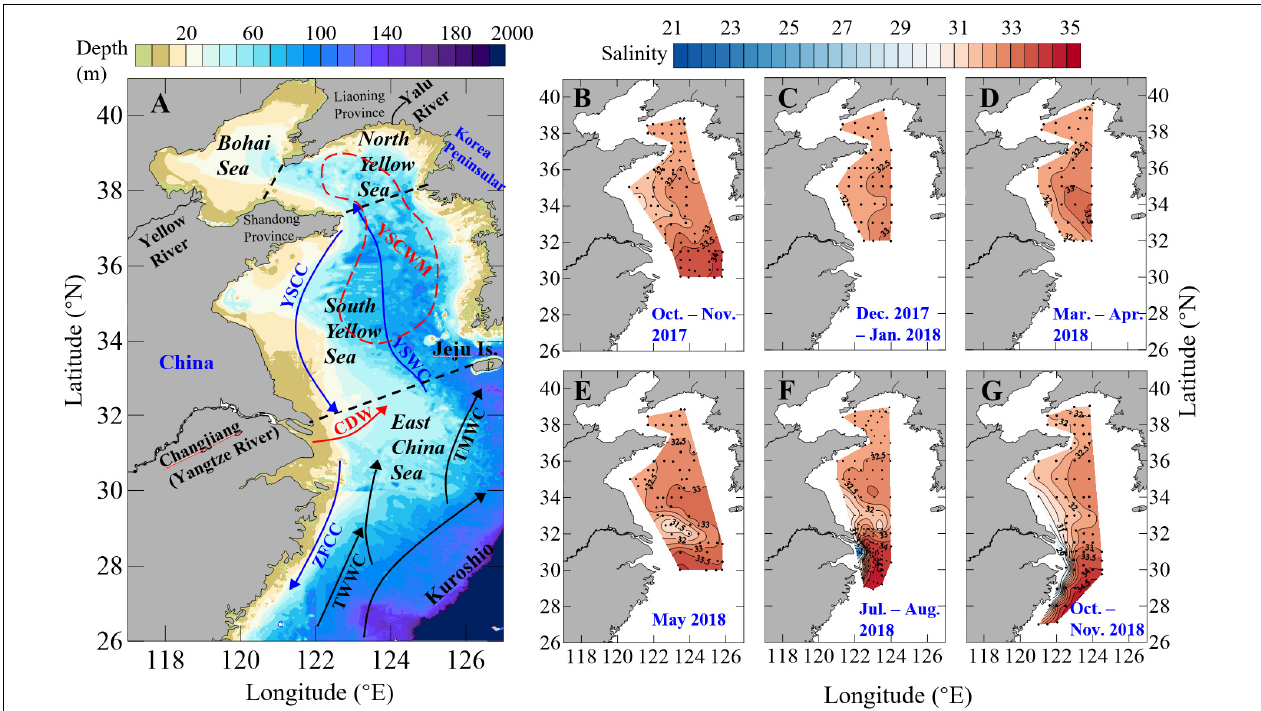
FIGURE 1 | Maps showing (A) the circulation and depth contour in the Yellow Sea and East China Sea, and (B–G) sampling sites together with our bottom-water salinity data during our seasonal mapping cruises in 2017–2018. In (A) , boundaries among the Bohai Sea, North Yellow Sea, South Yellow Sea and East China Sea are shown as dashed black lines. The year-round Kuroshio, TsushiMa Warm Current (TMWC) and TaiWan Warm Current (TWWC) are sketched with black arrows. The wintertime Yellow Sea Coastal Current (YSCC), Yellow Sea Warm Current (YSWC) and Zhejiang-Fujian Coastal Current (ZFCC) are sketched with blue arrows. The summertime Changjiang Dilute Water (CDW) and Yellow Sea Cold Water Mass (YSCWM) are sketched with the red arrow and the dashed red circle,